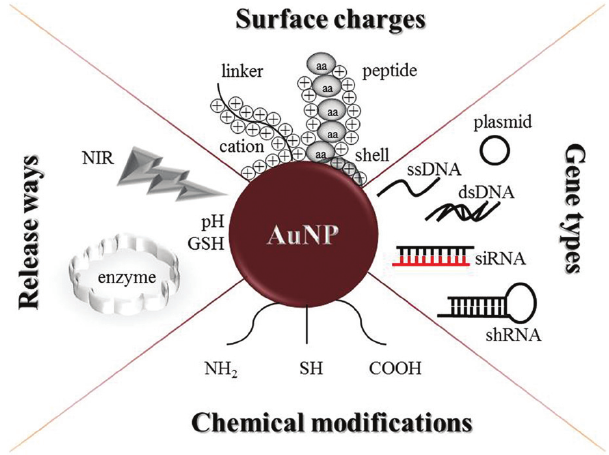
Fig. 1. Cationic surface charges and chemical modi¯cations of AuNPs are adapted to deliver therapeutic genes by NIR light, enzymatic lysis and microenvironment changes of tumor cells for cancer